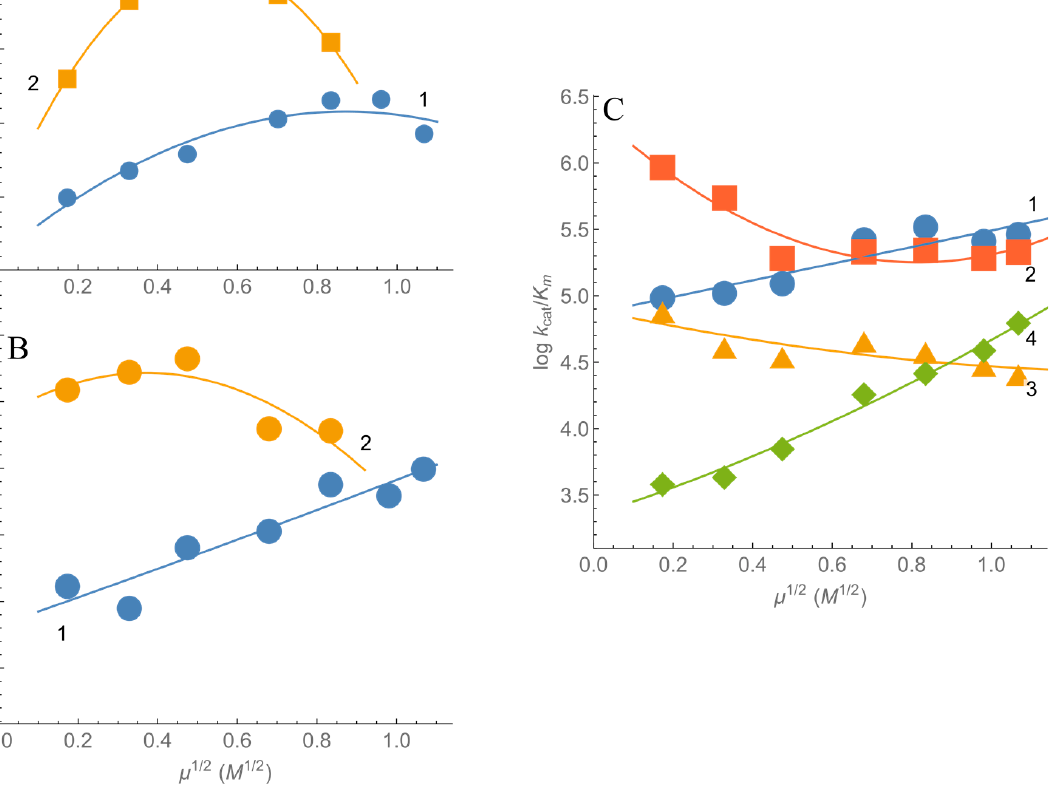
Figure 2. The effects of ionic strength on the reactivity of nNOS towards electron acceptors. ( A ) The dependence of k cat of duroquinone on the ionic strength in the absence of calmodulin (1, blue disks) and its presence (2, orange squares). ( B ) The dependence of k cat / K m of duroquinone on the ionic strength in the absence of calmodulin (1, blue disks), and its presence (2, orange disks). ( C ) The dependence of k cat / K m for ferricyanide (1, blue disks), cytochrome c (2, red squares), Fe(EDTA) − (3, green diamonds) and benzylviologen (4, orange triangles) on the ionic strength. [NADPH] = 50 µM, ionic strength varied by the addition of NaCl to 0.03 M Tris/HCl.